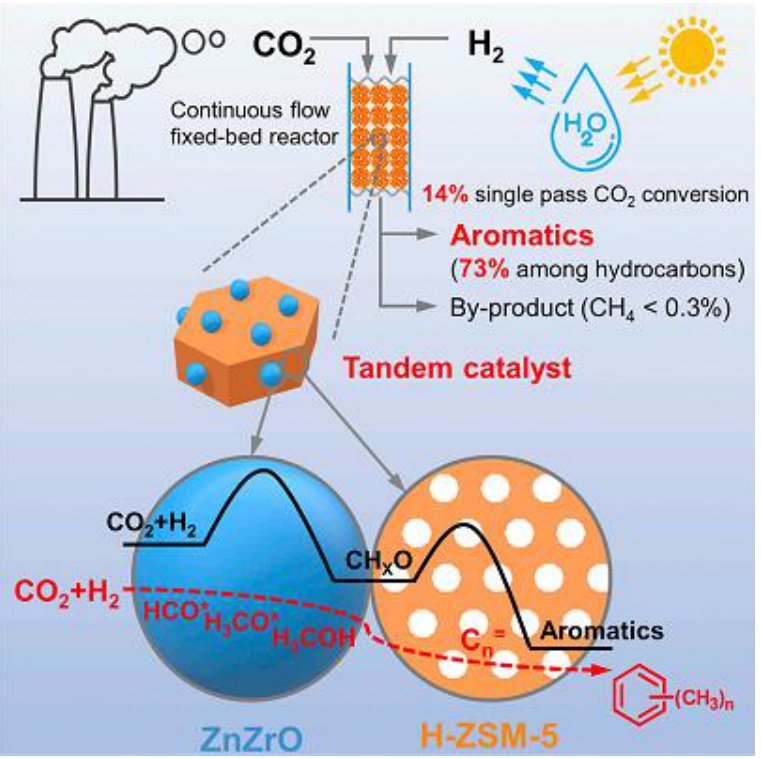
Figure 15. Reaction scheme of CO 2 hydrogenation to aromatics, reproduced with permission from [77]. Copyright Elsevier, 2019.